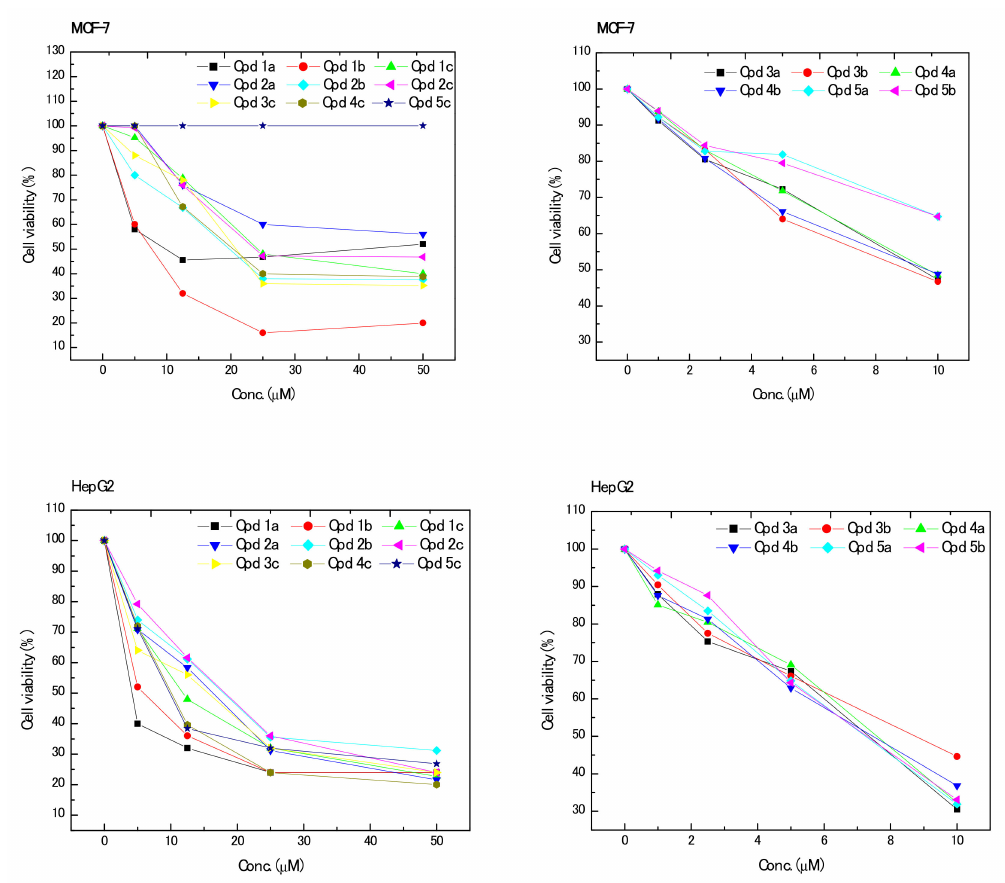
Figure 2. E ff ect of di ff erent concentrations of the prepared compounds on the viability of hepatocellular (HepG-2) and breast (MCF-7) cancer cell